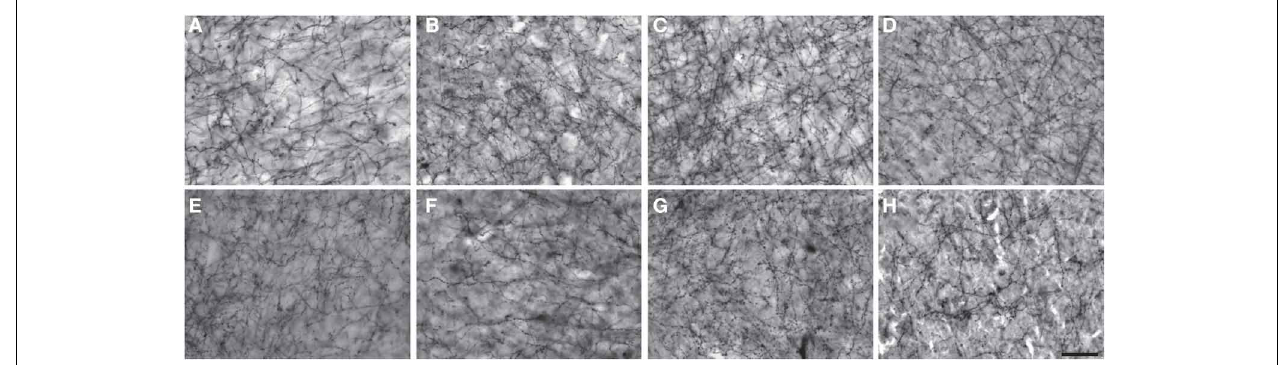
FIGURE 1 | Photomicrographs of NPY immunostaining in layer III of area 44 in (A) squirrel monkey, (B) capuchin, (C) moor macaque, (D) pigtailed macaque, (E) baboon, (F) gorilla, (G) chimpanzee, and (H) human. Scale bar = 50 μ m.